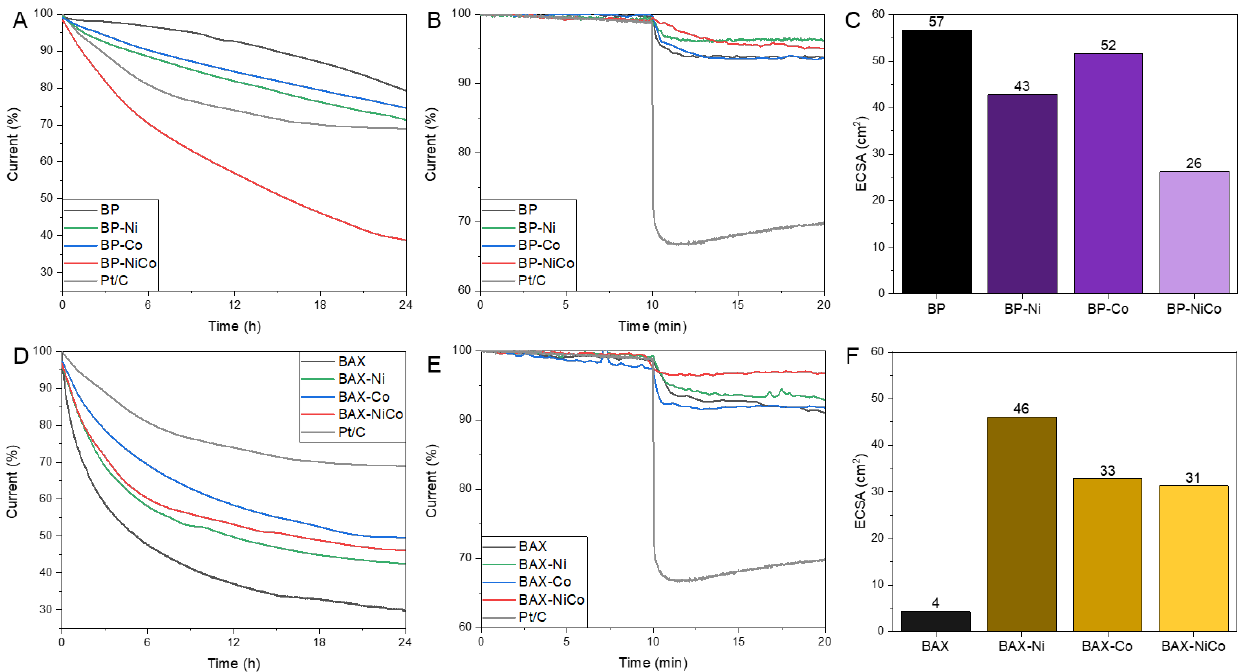
Figure 4. Stability of the BP series ( A ) and of the BAX ones ( D ); stability to methanol cross-over to the BP series ( B ) and BAX ones ( E ). ECSA of the BP ( C ) and BAX series ( F ).